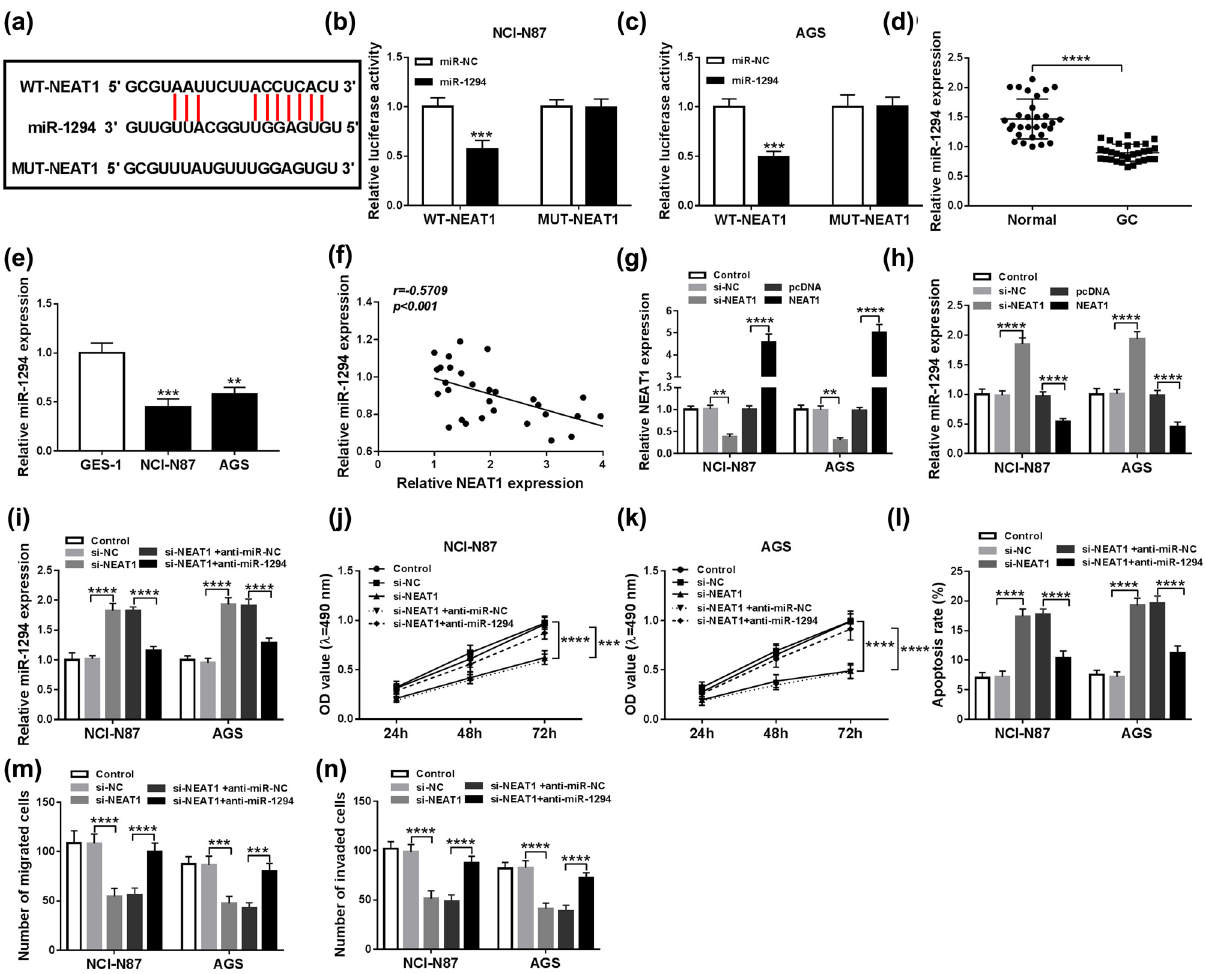
Figure 3: Down - regulation of miR - 1294 relieved the si - NEAT1 - induced e ff ects on proliferation, apoptosis, and metastasis of GC cells. ( a ) The binding sites of NEAT1 and miR - 1294 were predicted by Starbase v2.0. ( b and c ) Luciferase activity of NCI - N87 and AGS cells co - transfected with WT - NEAT1 or MUT - NEAT1 and miR - 1294 or miR - NC was measured by dual - luciferase reporter assay. ( d and e ) MiR - 1294 expression was examined by qRT - PCR in tissues and cells. ( f ) The linear relationship between NEAT1 and miR - 1294 in GC tissues was analyzed by Spearman ’ s correlation coe ffi cient. ( g ) QRT - PCR was used to detect the knockdown e ff ect of si - NEAT1 and overexpressed e ff ect of NEAT1.